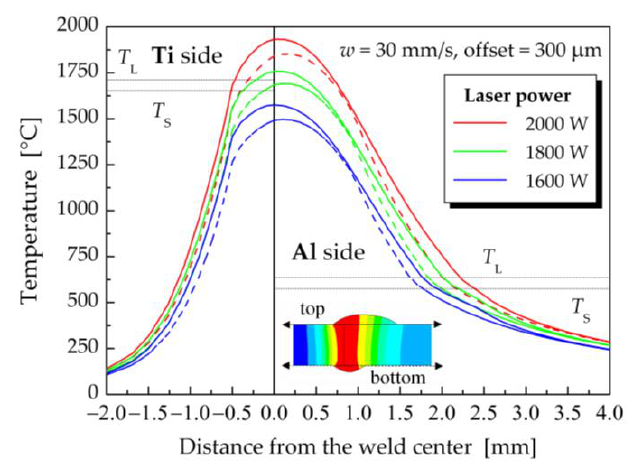
Figure 13. Dependence of temperature on the distance from the weld centerline for selected laser powers on the top surface (solid lines) and bottom surface (dashed lines) of the welded plates (a welding speed of 30 mm·s −1 and a laser beam offset of 300 μm).